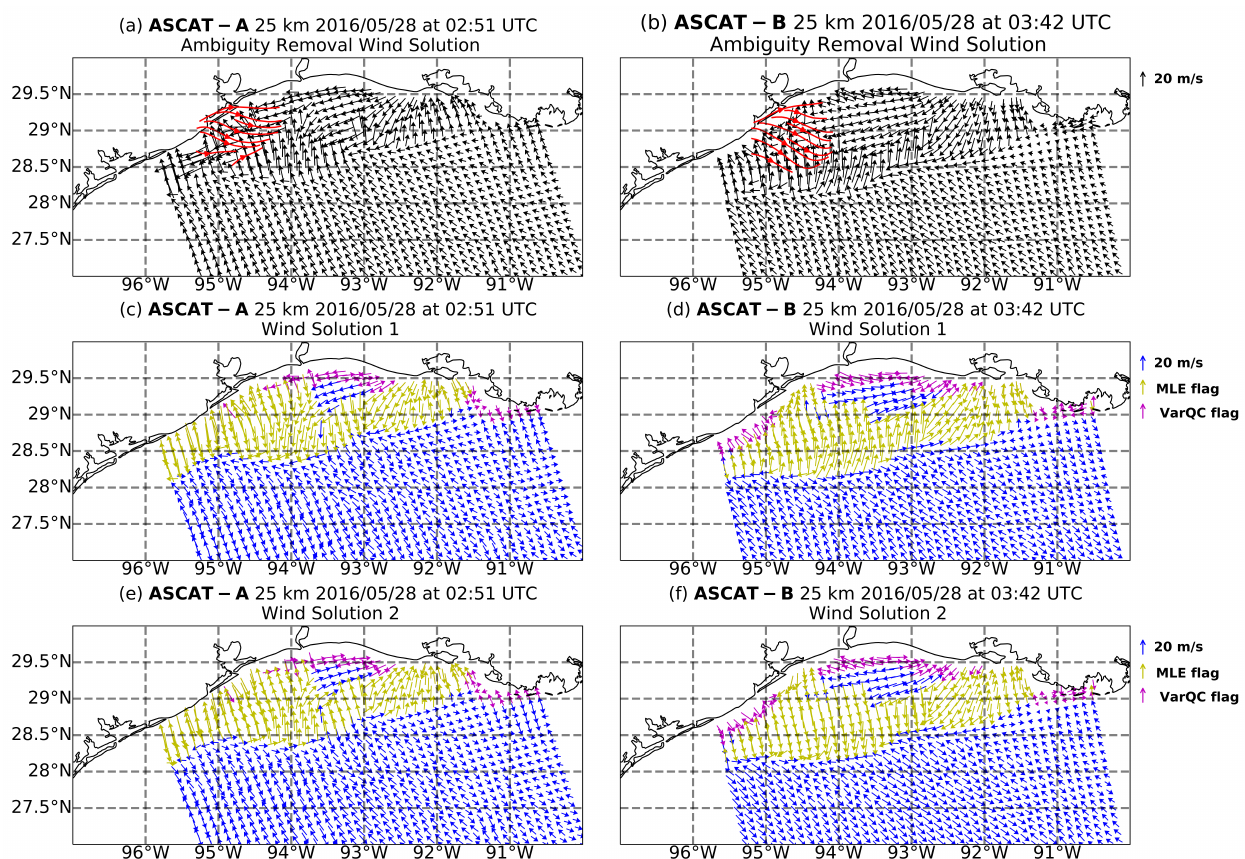
Figure 4. ASCAT-A and -B 25-km wind products on 28 May 2016 at 02:51 UTC and 03:42 UTC, respectively. The configuration is the same as in Figure